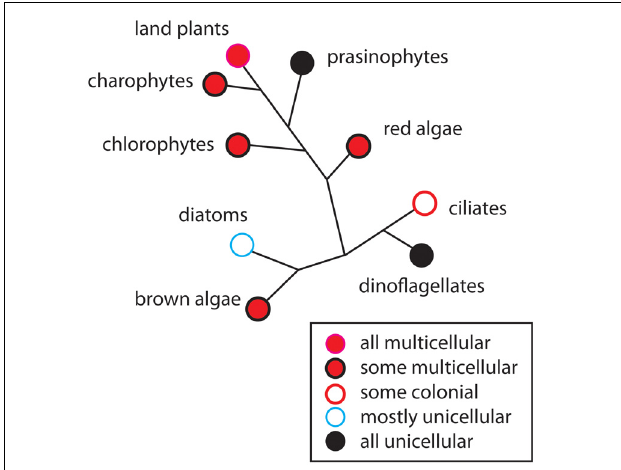
FIGURE 1 | The occurrence of multicellularity shown on a highly redacted and unrooted phylogenetic diagram of the major groups of photosynthetic eukaryotes. Although some groups are entirely unicellular or multicellular (e.g., prasinophytes and the land plants, respectively), most contain a mixture of body plans such as the unicellular and colonial body plans (e.g., diatoms), or a mixture of the unicellular, colonial, and multicellular body plans (e.g., brown algae). In general, early-divergent persistent lineages are dominated by unicellular species (e.g., prasinophytes in the green algal clade), whereas later-divergent lineages contain a mixture of body plans (e.g., chlorophytes and charophytes). Species-rich, late-divergent persistent lineages tend to be exclusively multicellular (e.g., the land plants and